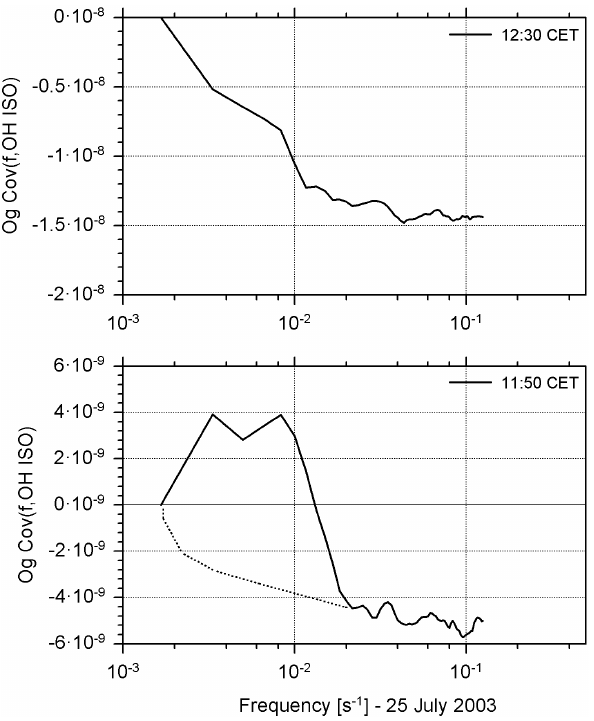
Figure 17. The spectral presentation of the ogives of the covari- ance of OH and isoprene for the maximum of I S at 12:30CET, and the minimum of I S at 11:50CET when both parts compensate each other and apparently result in I S ’ 0 (see Sect. 5.3.4). The broken line for the results at 11:50CET shows a possible behaviour of the ogive if only inhomogeneous mixing